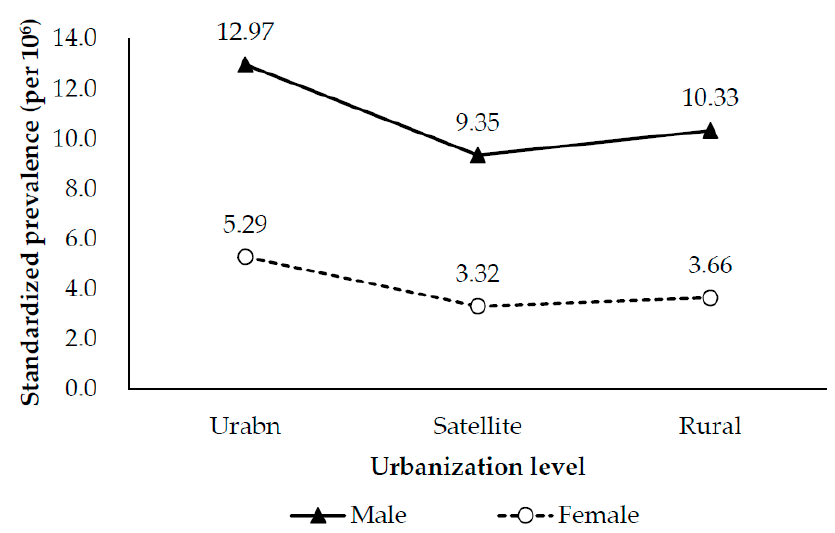
Figure 4. Age ‐ standardized biennial prevalence rates of liver transplantation for men and women living with different levels of urbanization.